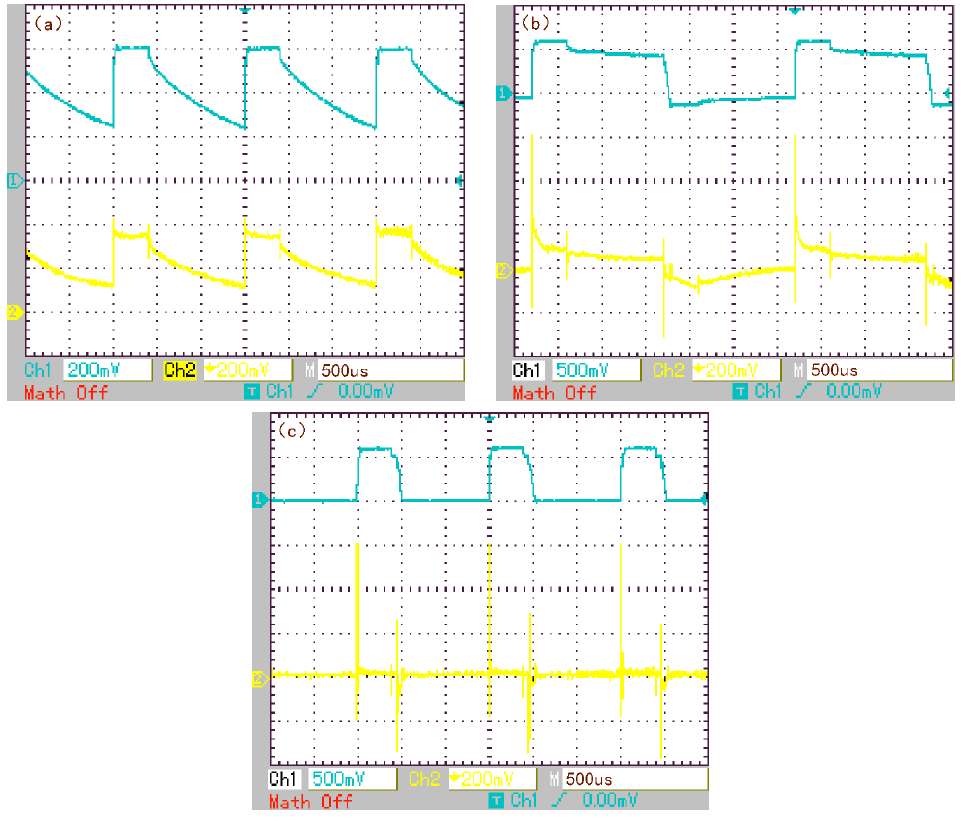
Figure 3. Load waveform of the voltage (upper) and current (following) based on pulsed direct current ( a ), pulsed bipolar current ( b ) and the pulsed with a discharge loop current ( c ) power supply mode.